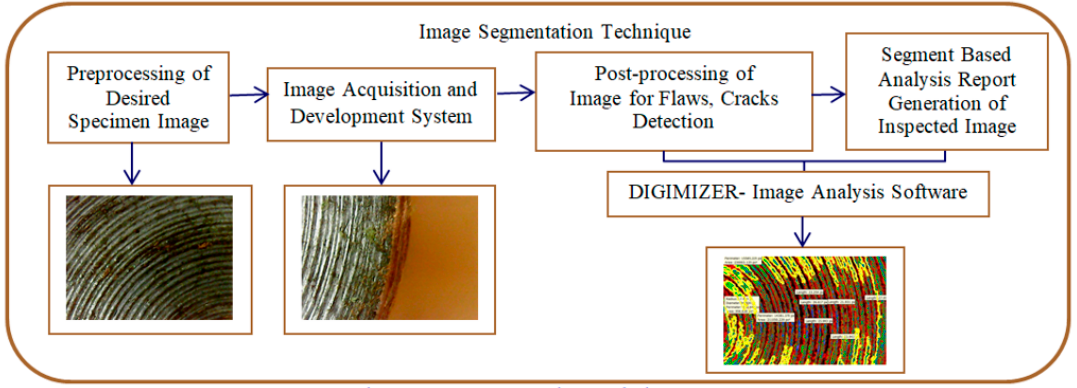
Figure 2. Procedural steps of the image segmentation technique.